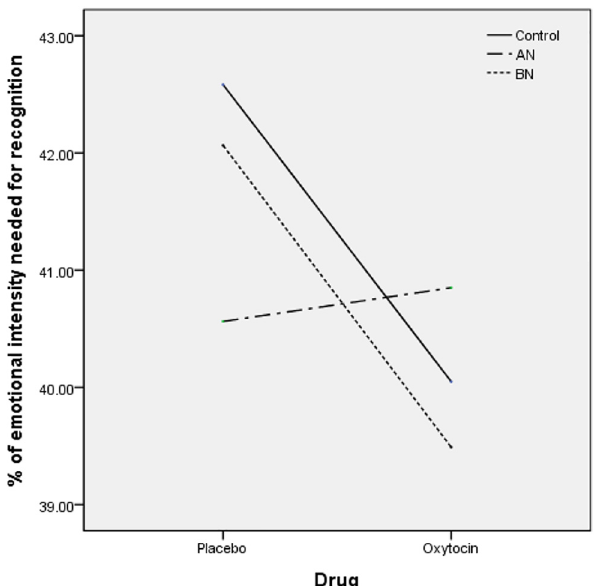
Fig 3. Emotional intensity for accurate emotion identification of total emotion under oxytocin/placebo conditions. There was a main effect of drug [F(1,99) = 5.172, p = 0.025, Δη 2 = 0.053], in which oxytocin increased the sensitivity of overall emotional recognition with a small effect size in the healthy women (d = 0.311) and the patients with BN (d = 0.315). AN, anorexia nervosa; BN, bulimia